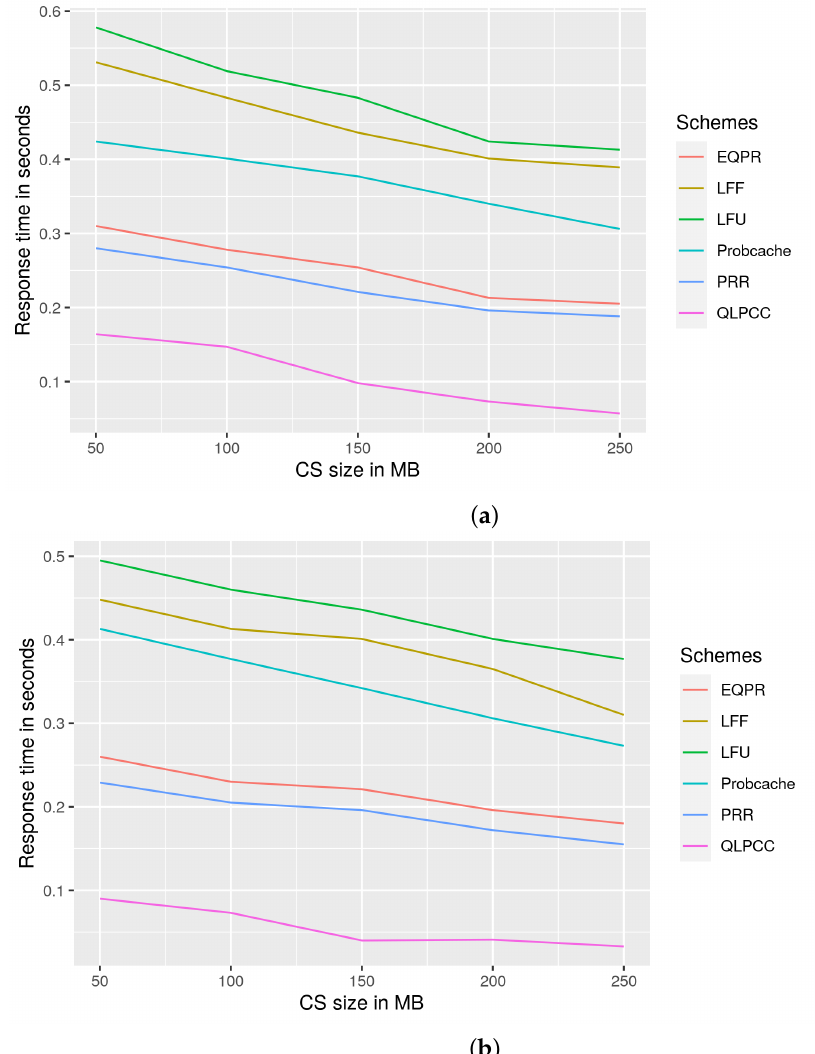
Figure 7. Response time vs. QoS-node content store size for QoS traffic. ( a ) Response time vs. QoS-node content store size (QoS traffic) for | M | = 500. ( b ) Response time vs. QoS-node content store size (QoS traffic) for | M | =